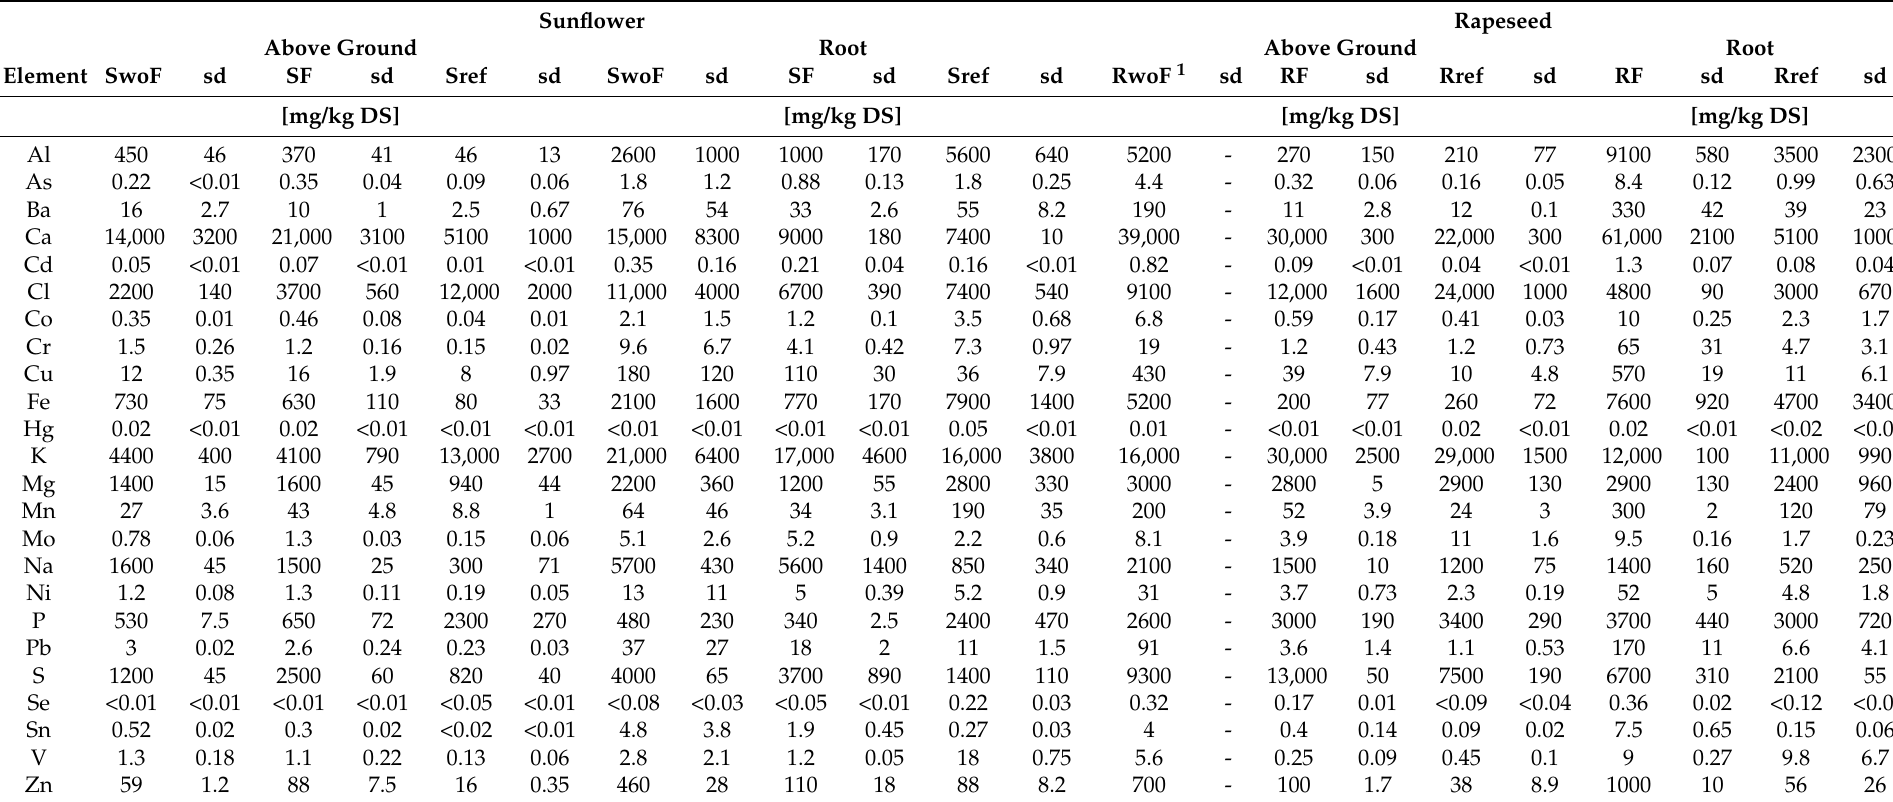
Table 3. Total amounts in parts above ground and roots from sunflower and rapeseed cultivated in MIBA, with or without fertilizer, and in reference soil. All values are shown in mg/kg